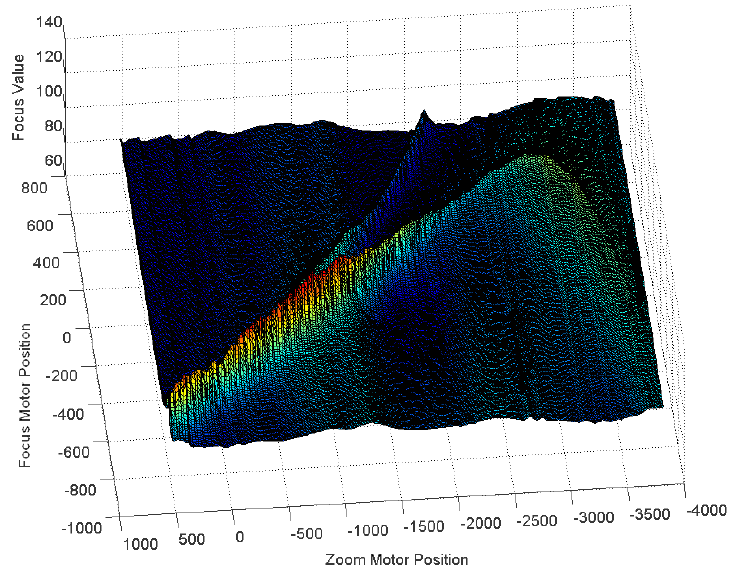
Figure 23. One example of FZT